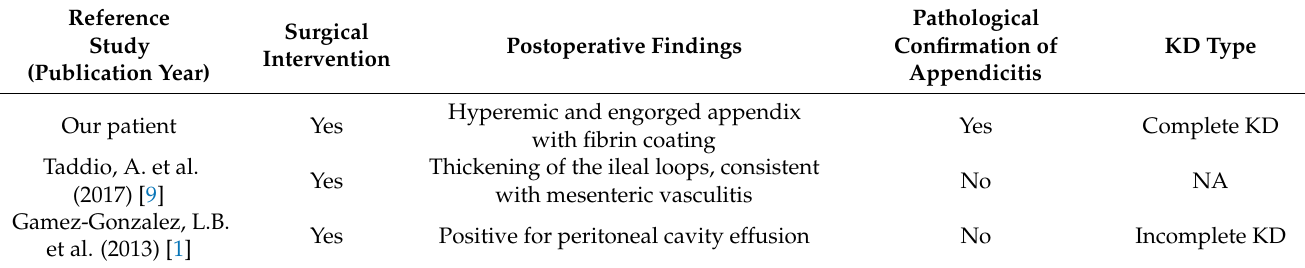
Table 1. Clinical characteristics of Kawasaki Disease Shock Syndrome with appendicitis in 3